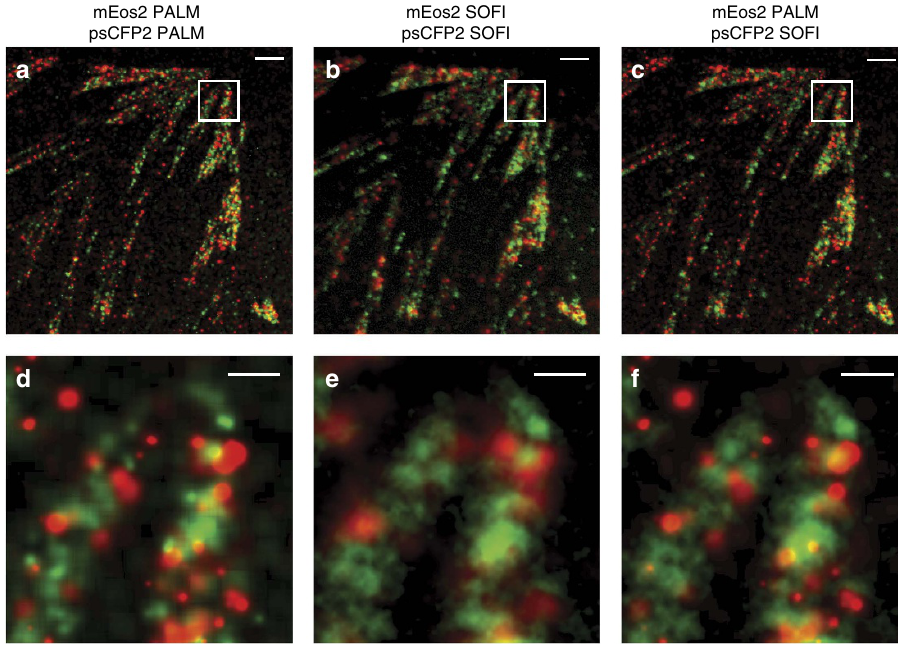
Figure 2 | Dual-colour imaging with PALM and SOFI. ( a – c ) Overlay of red and green images of a fixed REF cell expressing paxillin labelled with psCFP2 (green) and integrin b 3 labelled with mEos2 (red) as obtained by ( a ) PALM in both colour channels, ( b ) SOFI in both colour channels, and ( c ) PALM in the red channel and SOFI in the green channel. ( d – f ) Corresponding zoom-ins for the images in a – c . The PALM images were rendered as probability maps (see Methods). Scale bar, 2 m m ( a – c ); 0.5 m m ( d – f